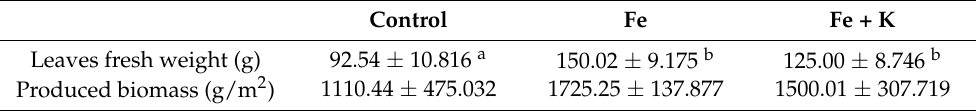
Table 6. Rocket growth performance as assessed by the fresh weight of leaves per plant and the marketable produced biomass per unit area. Data are expressed as means ± S.E.M ( n = 36 for leaves fresh weight and n = 3 for total produced biomass). Means in a row followed by different superscript are significantly different ( p >